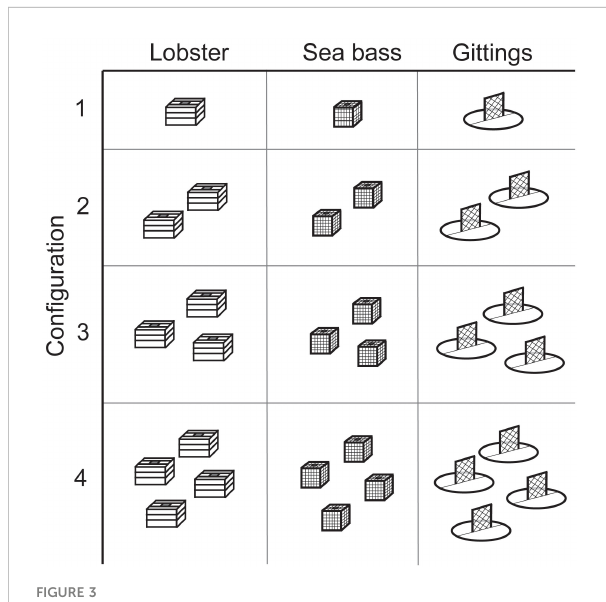
FIGURE 3 Schematic showing the matrix of trap type and con fi guration deployed at each reef